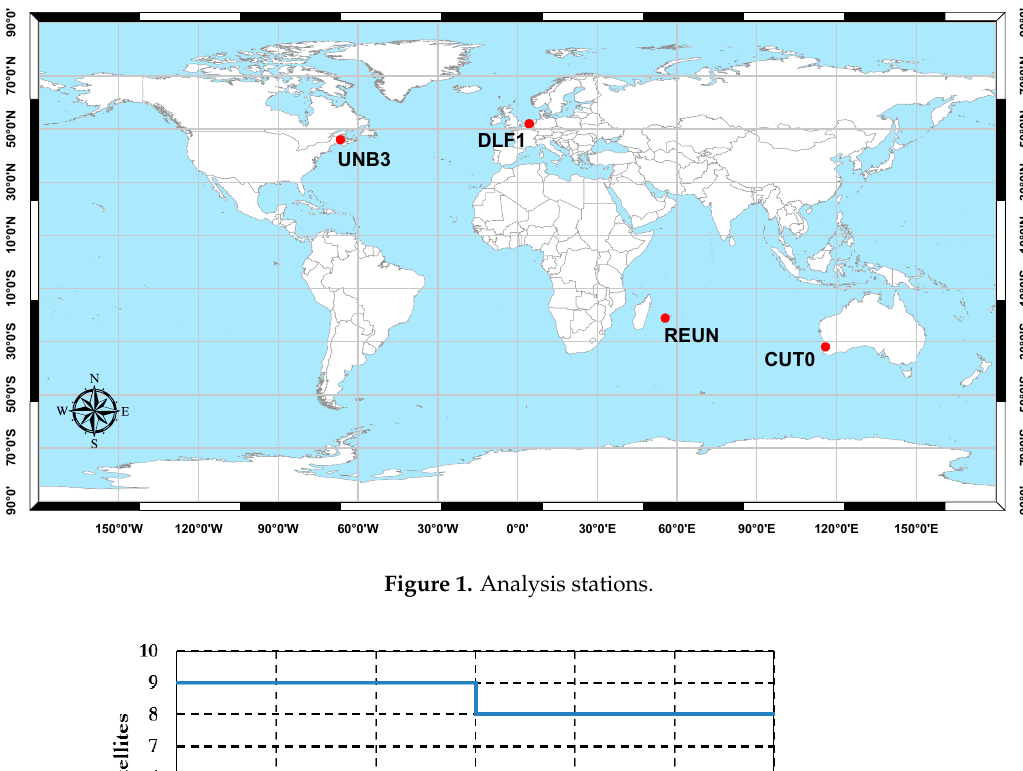
Figure 1. Analysis stations.